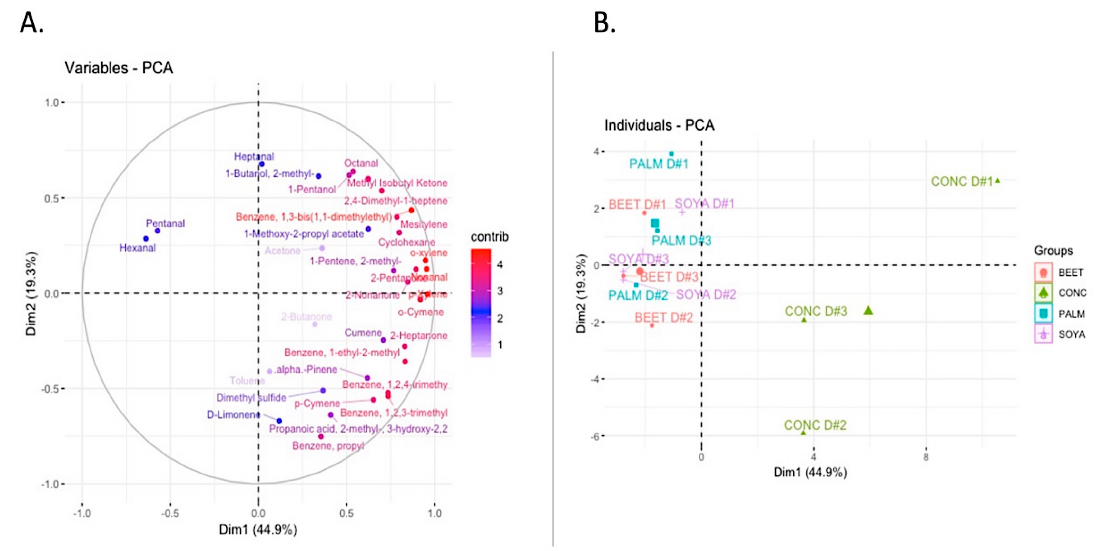
Figure 2. Principal component analysis of volatile compounds detected from milks from each of the diets, parlour concentrate (CONC), palm kernel expeller (PALM), soya hulls (SOYA), and molassed beet pulp (BEET).